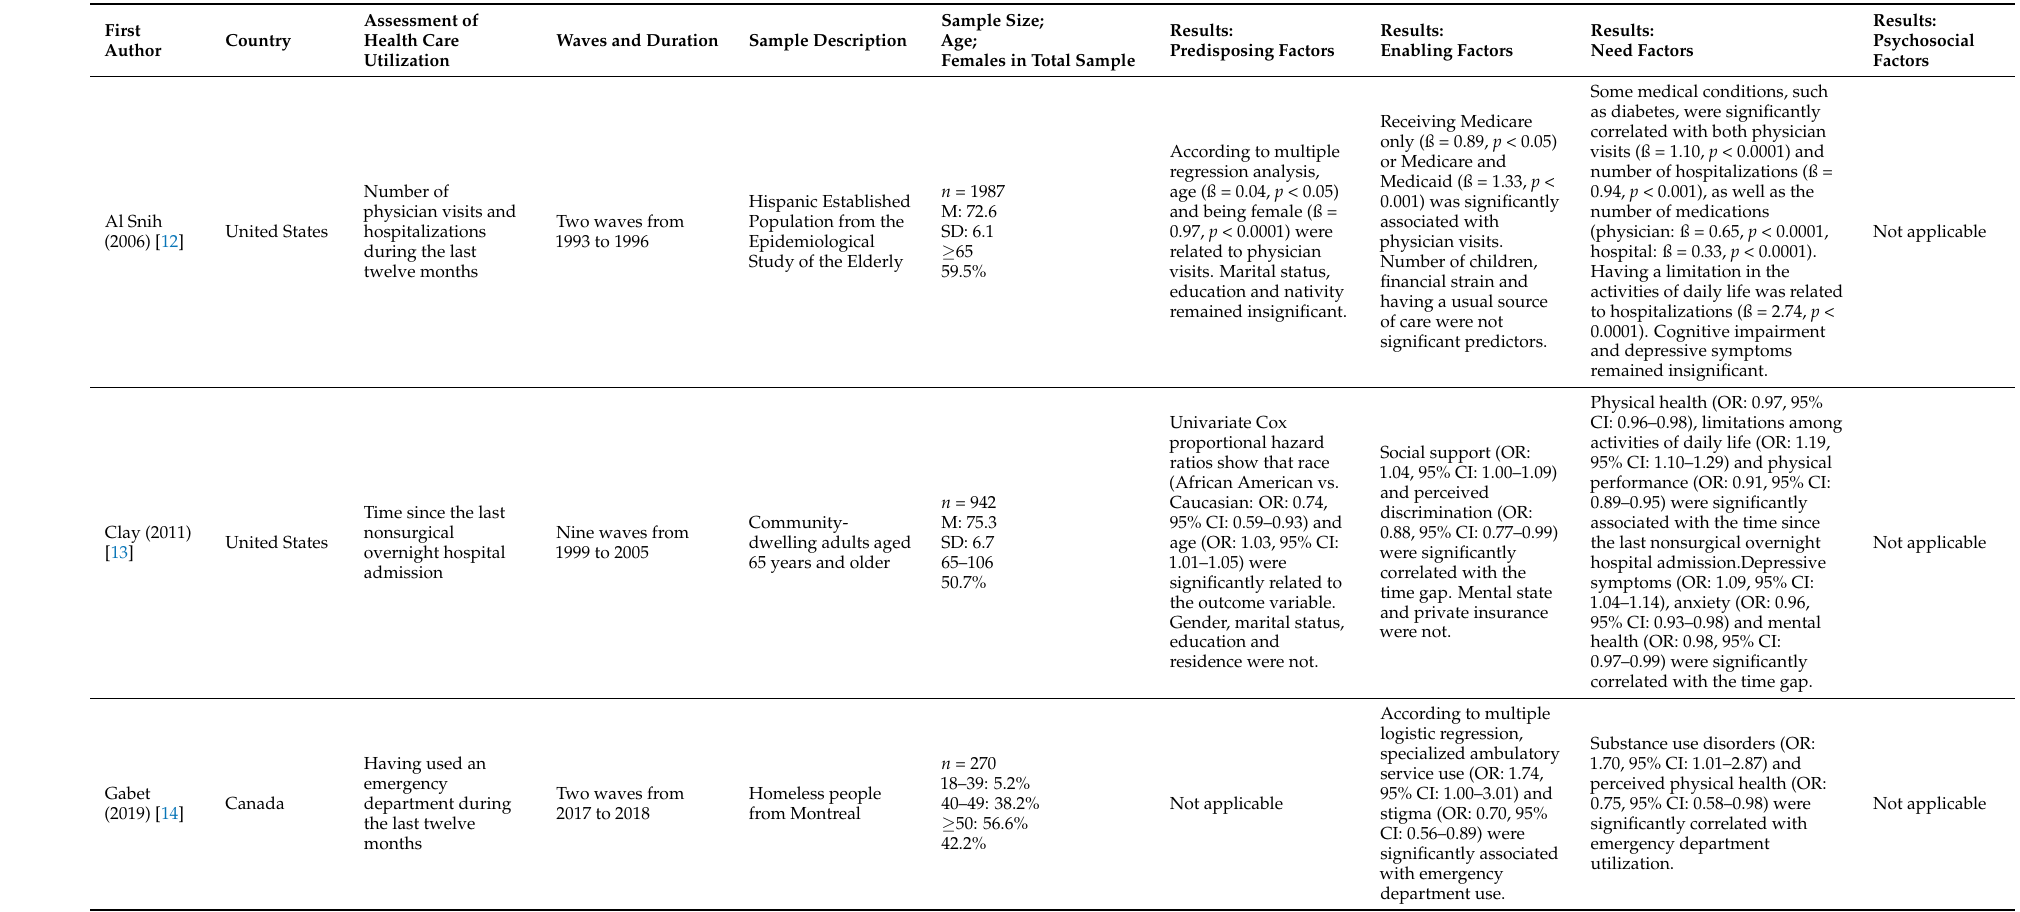
Table 2. Key characteristics and main findings of studies included in the final synthesis ( n =